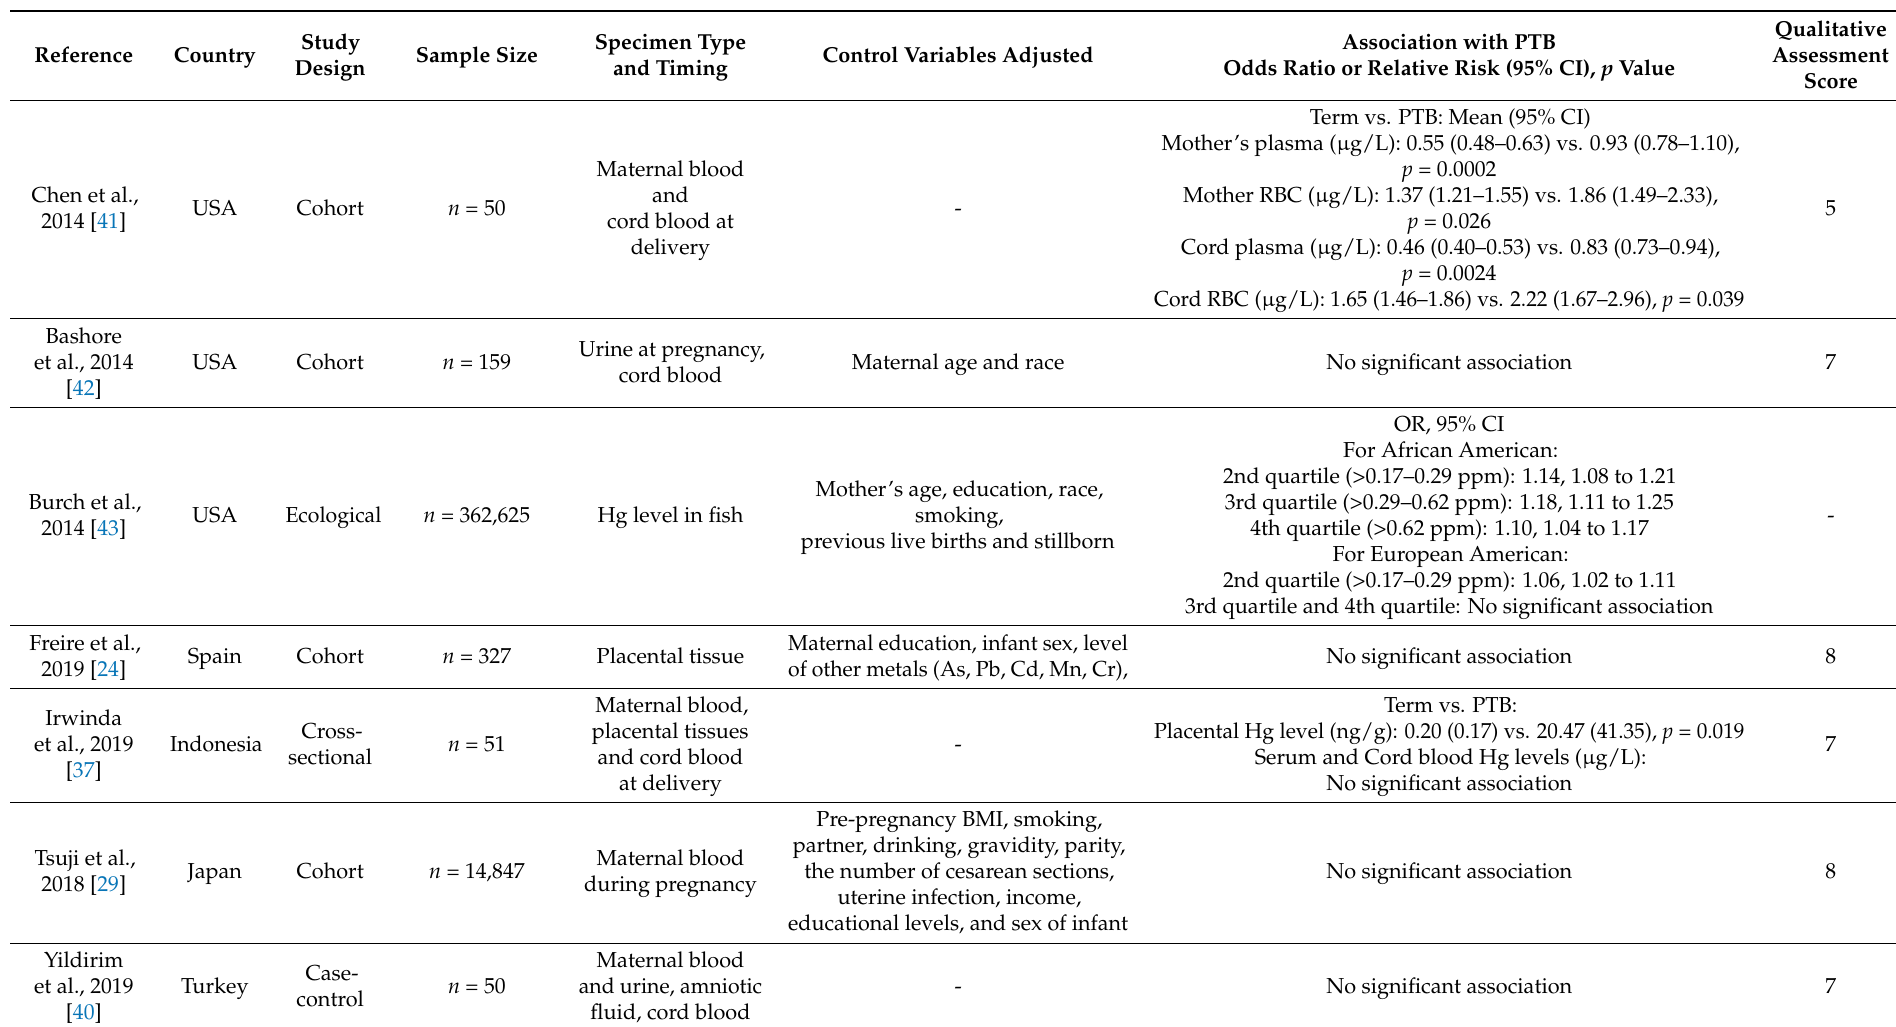
Table 2. Association between Mercury and